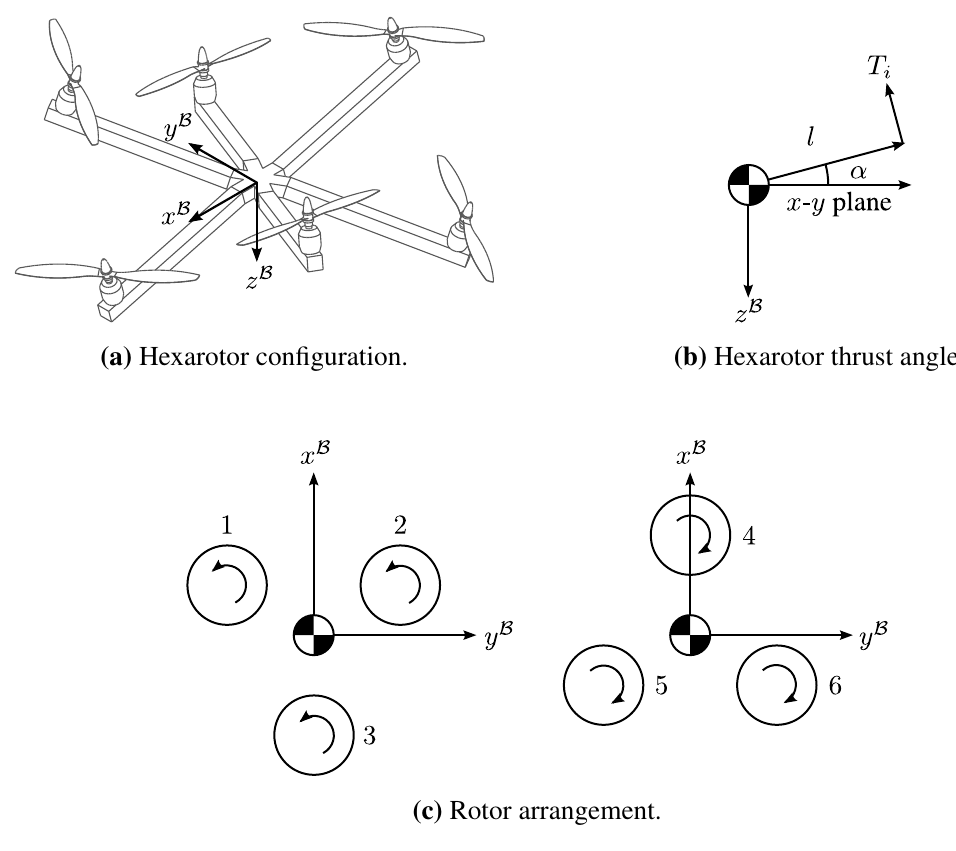
Figure 3. Hexarotor configuration and the axes’